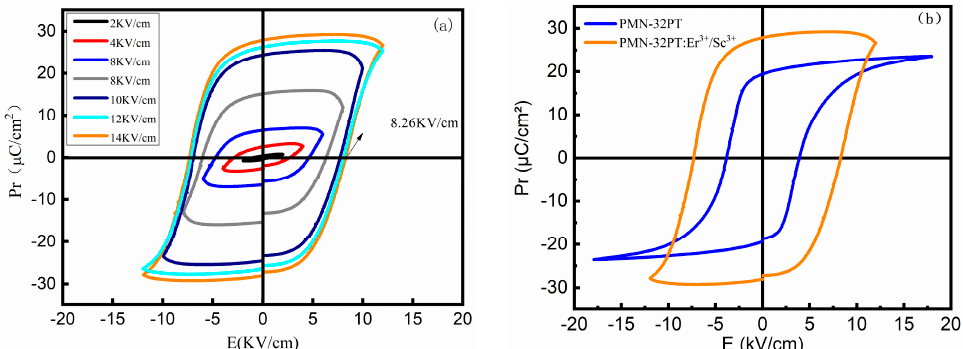
Figure 3. Polarization versus electric field ( P–E ) hysteresis loops of PMN-32PT:Er 3+ /Sc 3+ crystal ( a ) P–E hysteresis loops at different electric fields ( b ) P–E hysteresis loops of the crystals PMN-32PT:Er 3+ /Sc 3+ and PMN-32PT at saturated state.